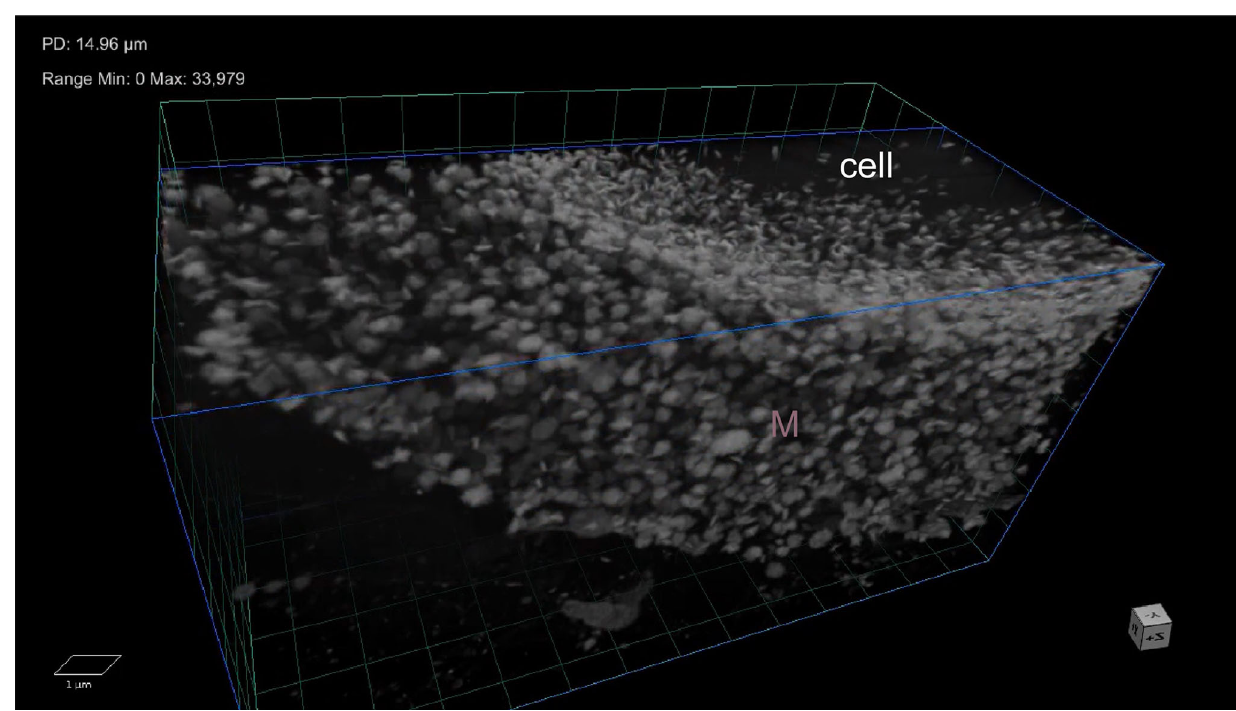
Fig. 5 FIB-SEM nanotomography reconstruction from P163. 3D reconstruction of part of the ROI from P163, showing the spatial relationships between the Mg-clay nanocrystals (M) and the cell, densest around the cell sheath, with more dispersed rosettes at the exterior of the cell and individual crystals at the interior. 3D video reconstruction is available as Supplementary Video SV1.